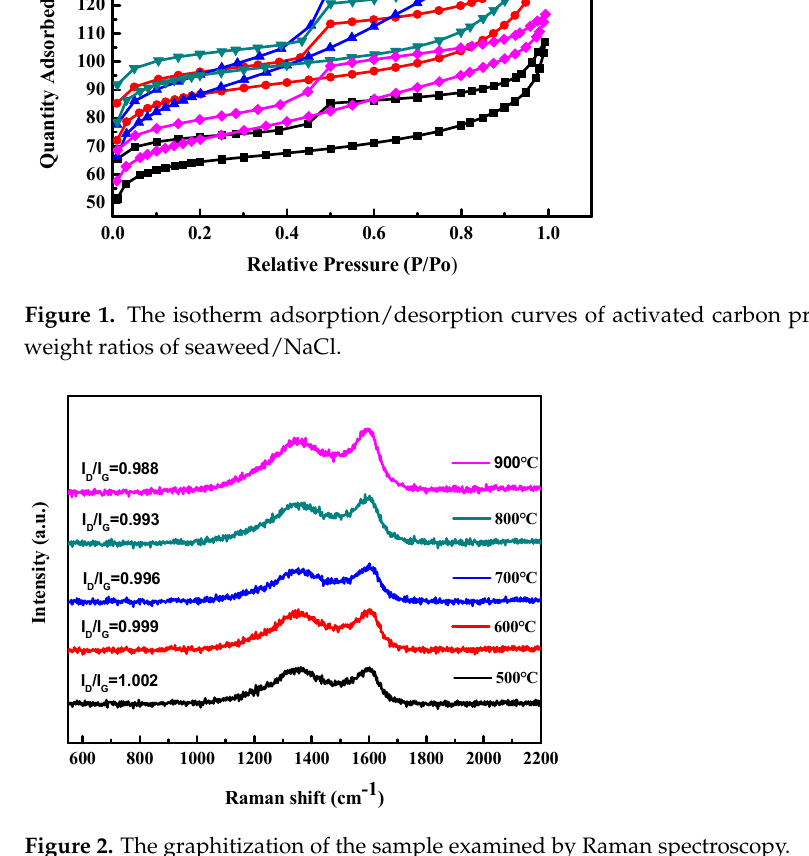
Figure 2. The graphitization of the sample examined by Raman spectroscopy.